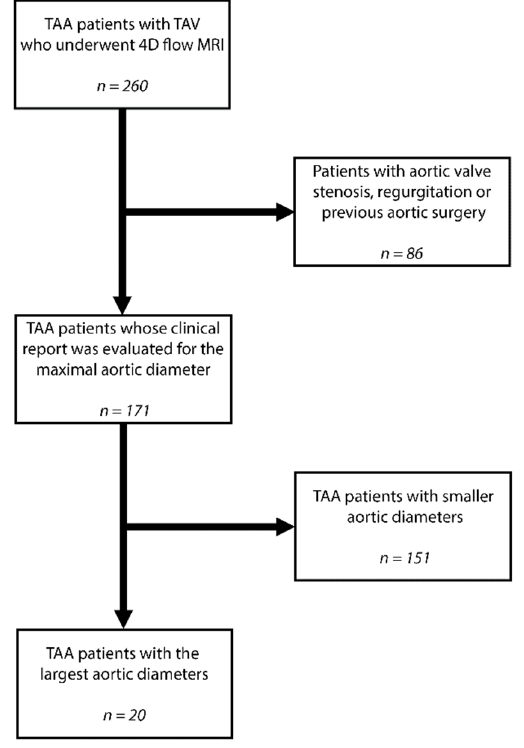
Figure 1. Population selection diagram. Abbreviations: TAA—thoracic aortic aneurysm, TAV— tricuspid aortic valve, MRI—magnetic resonance imaging, and 4D—four dimensional.